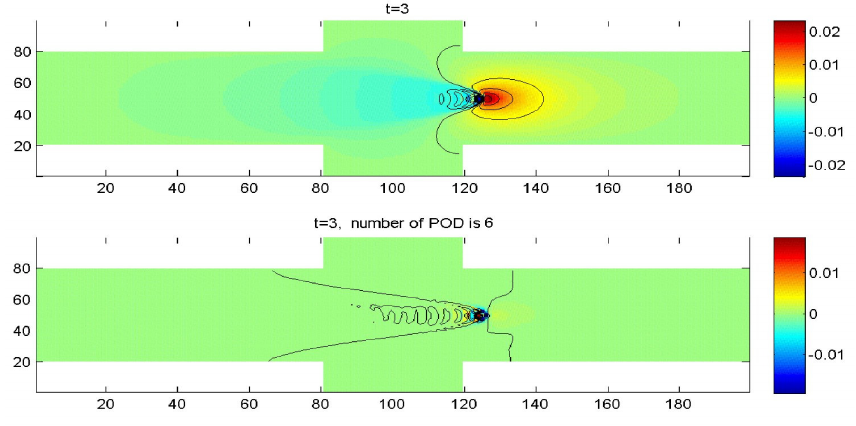
Figure 4. Top chart is the classical SCNMFE solution of velocity u and bottom chart is the POD-based reduced-order SCNMFE solution of velocity u with 6 POD bases when Re = 1000 and Pr = 7 at time t = 3.